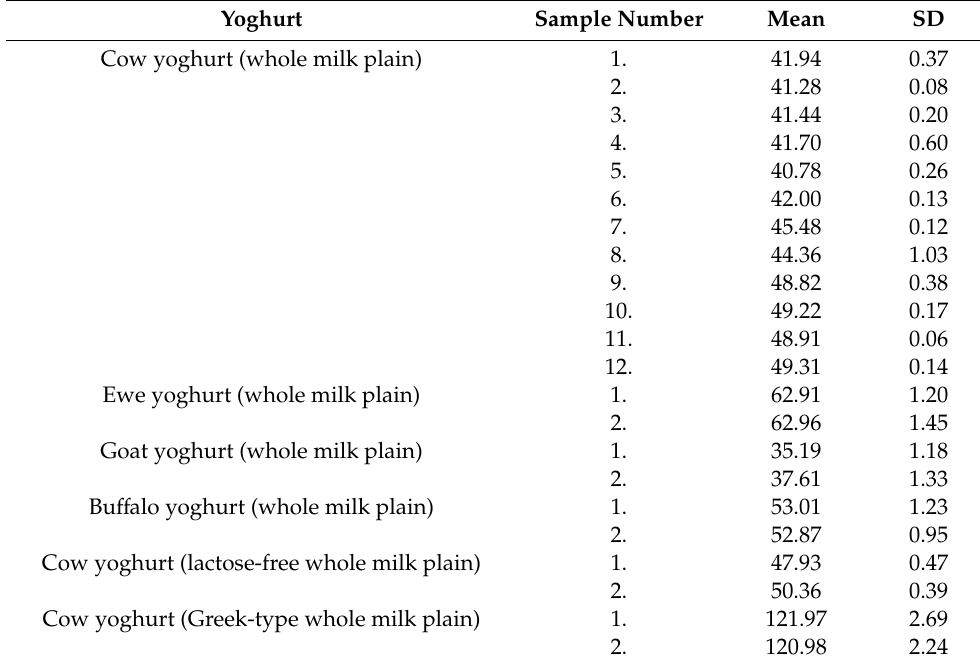
Table 4. TRP contents (mg / 100g) in commercial yoghurts from milk of di ff erent animal